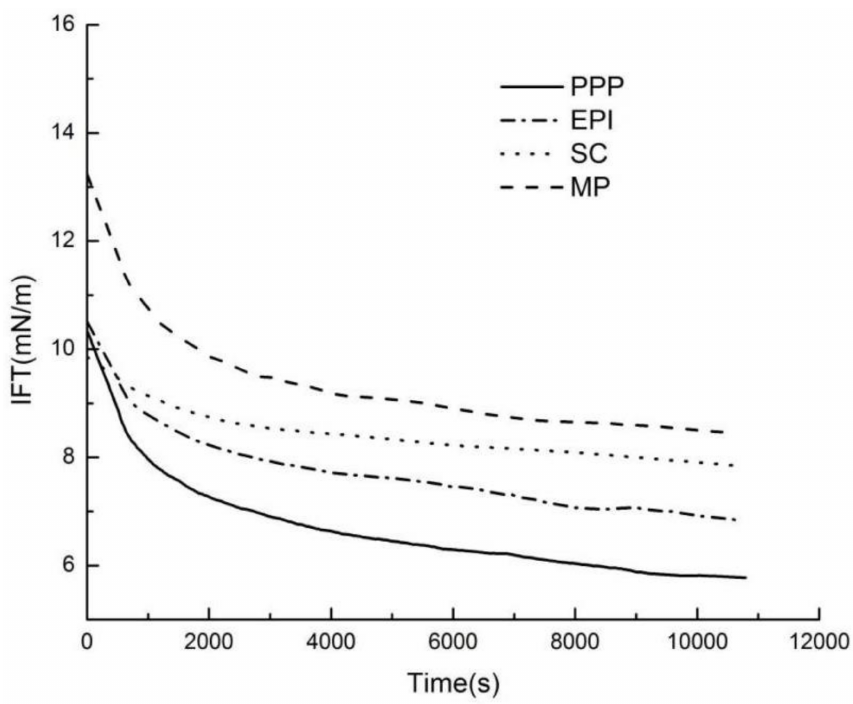
Figure 2. Dynamic interfacial tension of proteins at the O/W interface. PPP: porcine plasma protein; EPI: egg-white protein isolate; SC: sodium caseinate; MP: myofibrillar